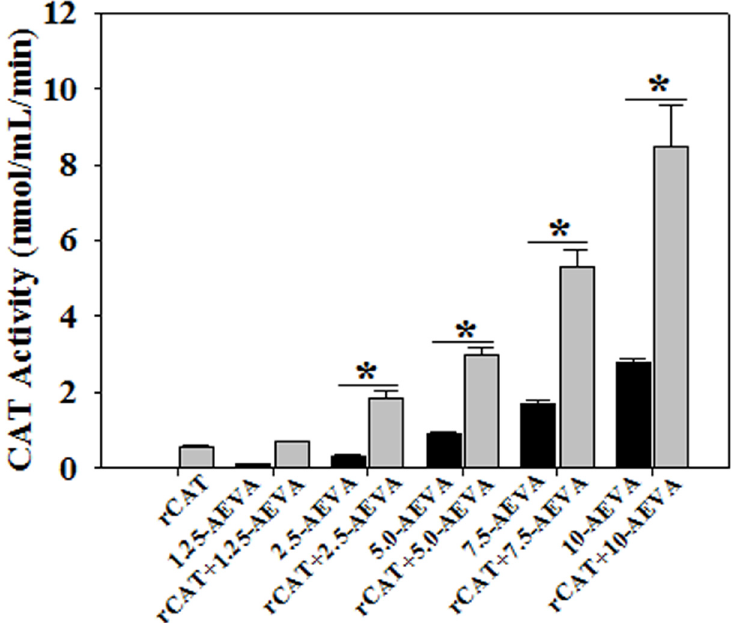
Fig 9. Dose dependent effect of AEVA on CAT activity using recombinant CAT (rCAT). 100 μ L of rCAT (100 μ g/mL) was incubated with different concentration of AEVA (1.25, 2.50, 5.00, 7.50, and 10.00 μ g μ L -1 ) for 2 h at 37°C. “ * ” indicates the significant difference between “ AEVA alone ” and “ rCAT + AEVA ” at the respective concentration of AEVA ( p * < 0.05). Values are mean ± SE (n =